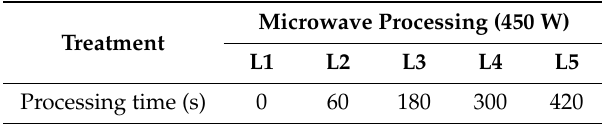
Table 1. Experimental design with the